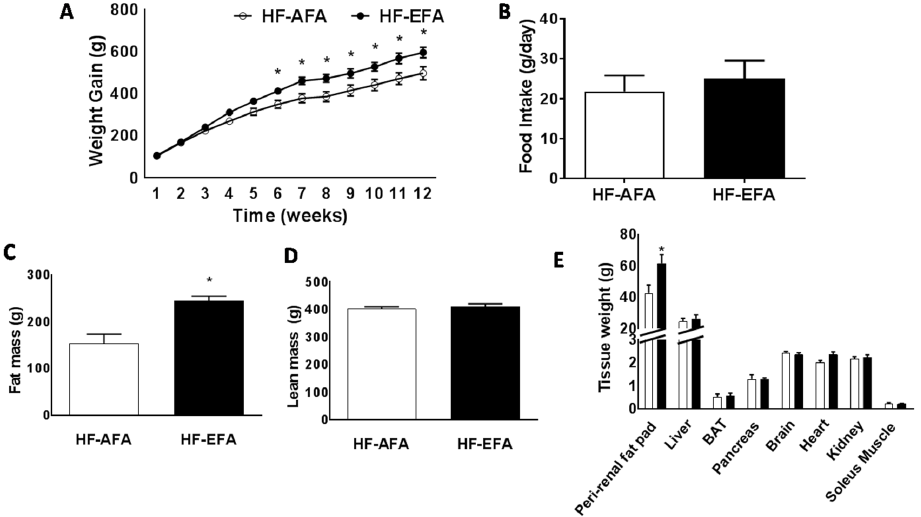
Figure 2. Excess folic acid intake increases weight gain and fat mass on a high fat diet. ( A ) Growth curves; ( B ) food intake; ( C ) fat mass; ( D ) lean mass; and ( E ) tissue weights. Values are means ± SEM, * p < 0.05.